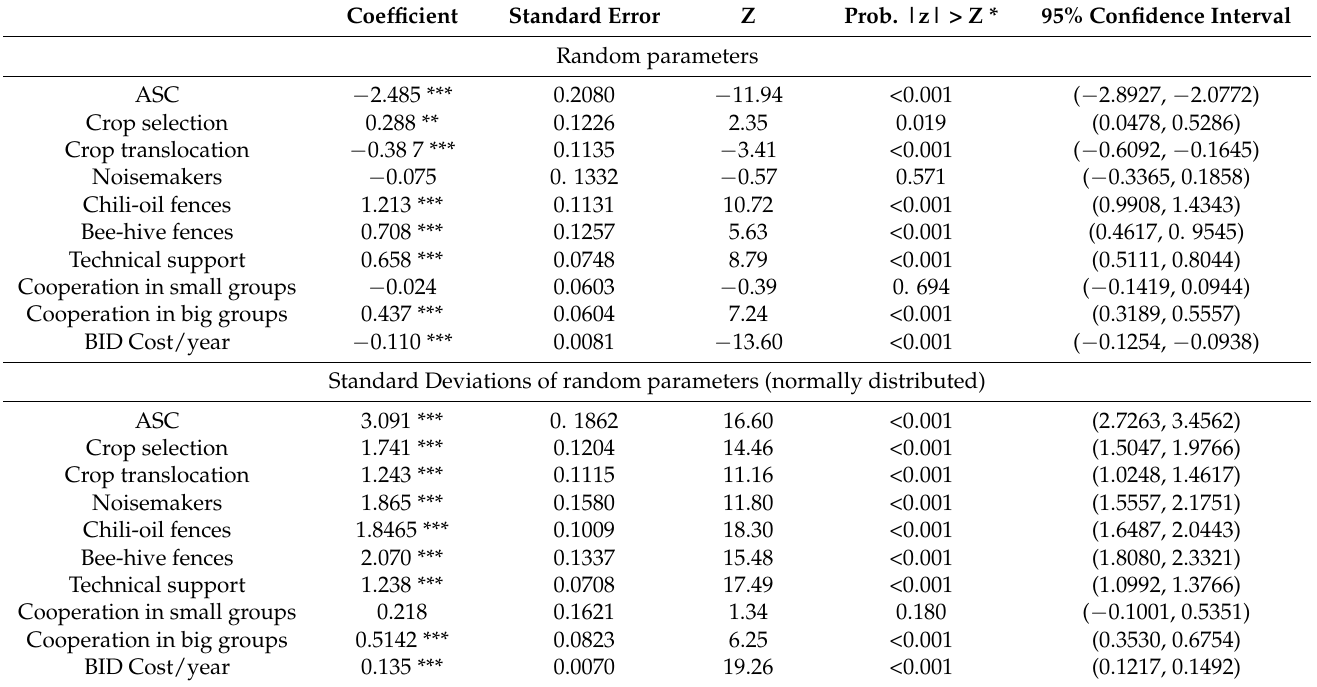
Figure 5. Description of the classes regarding the percentage of respondents that had seen an ele- phant (blue bar) and the percentage of respondents that had suffered a food shortage in their house- holds (grey bar). The line shows the average duration of the food shortage period (in months). Class 1: Affected and cooperative; Class 2: Not affected and cooperation in small groups; Class 3: Not affected and communal; Class 4: Affected and individualist; Class 5: Not affected whose family, friends, or neighbors have been affected and individualist.